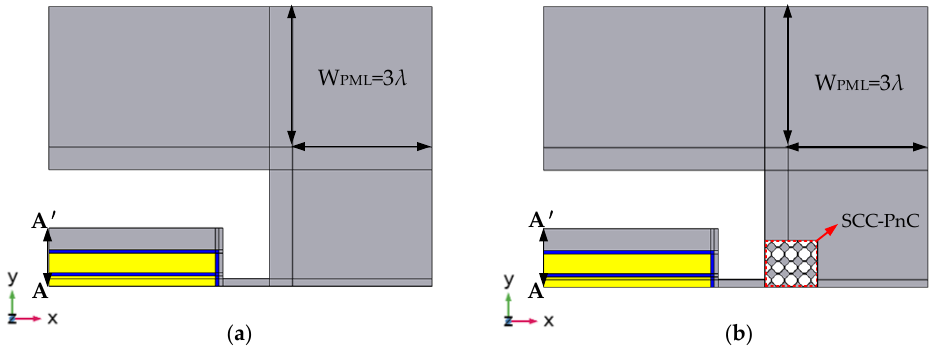
Figure 8. Simulation diagrams of quarter piezoelectric MEMS resonators: ( a ) traditional type piezo- electric MEMS resonator; ( b ) piezoelectric MEMS resonator with 4 × 7 SCC-PnC array plate.